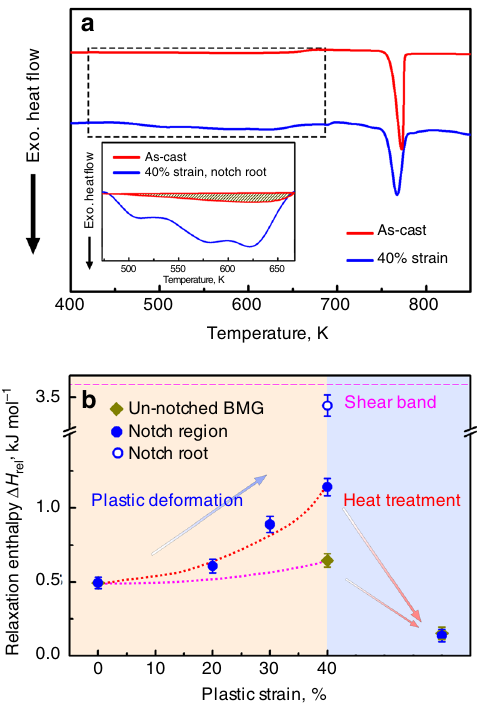
Fig. 4 Extreme rejuvenation by compression of notched glass specimens. a Differential scanning calorimetry traces (heating rate 20 K min – 1 ) of Zr 64.13 Cu 15.75 Ni 10.12 Al 10 glass: an as-cast specimen and a notched specimen compressed to 40% nominal strain. b Relaxation enthalpy Δ H rel of specimens of this glass compressed to different strains and annealed. The 4 is also given. Error bars are the Δ H rel value at the heart of a shear band standard deviation for the